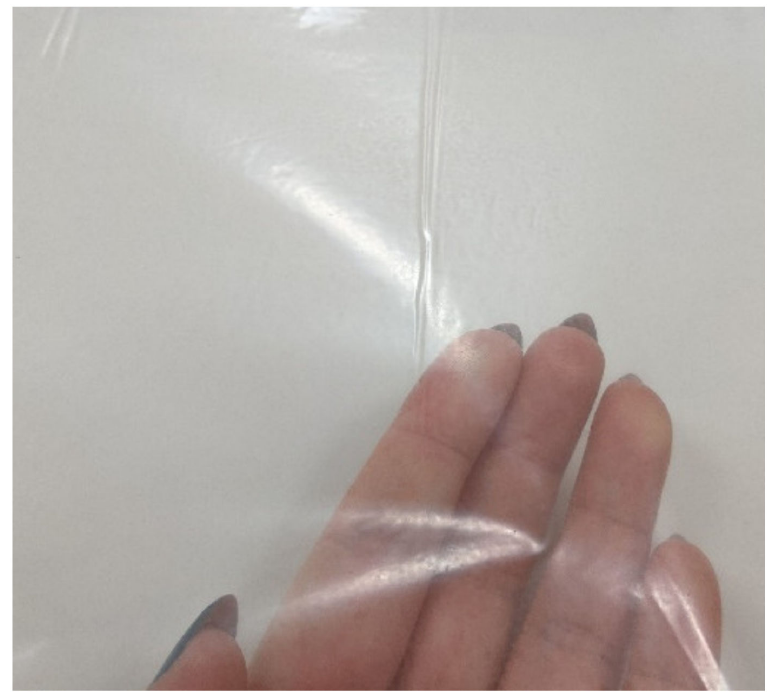
Figure 5. The active coatings containing M1 mixture as active compound in